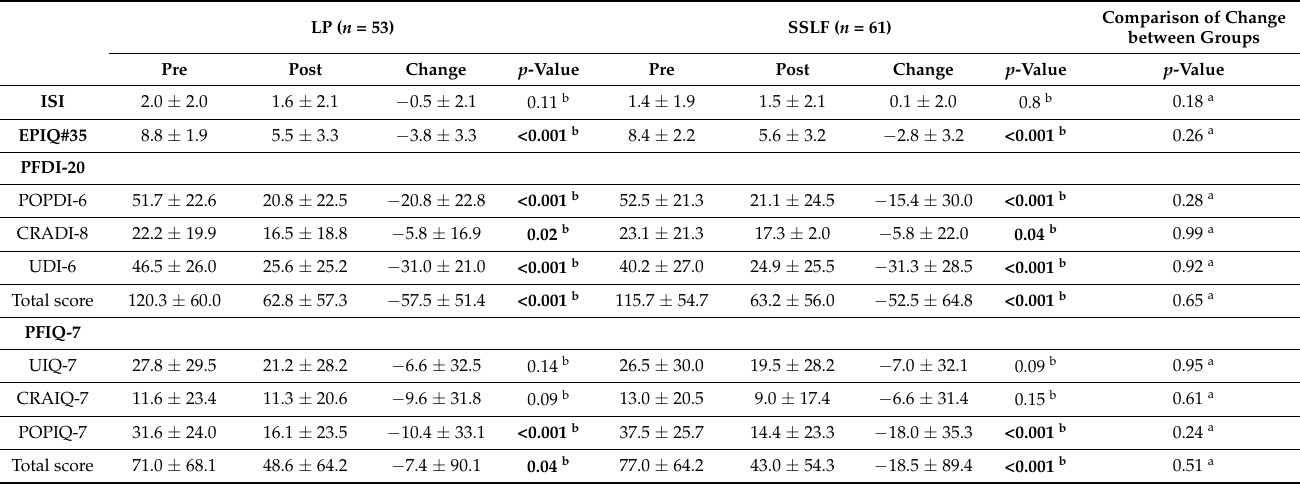
Table 6. Subjective outcomes—part 2: mean scores of questionnaires.